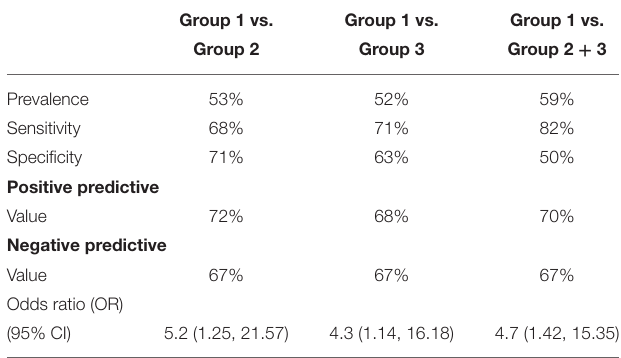
TABLE 2 | Logistic regression for prediction of disability in 5 years by baseline thalamic volume. Variable